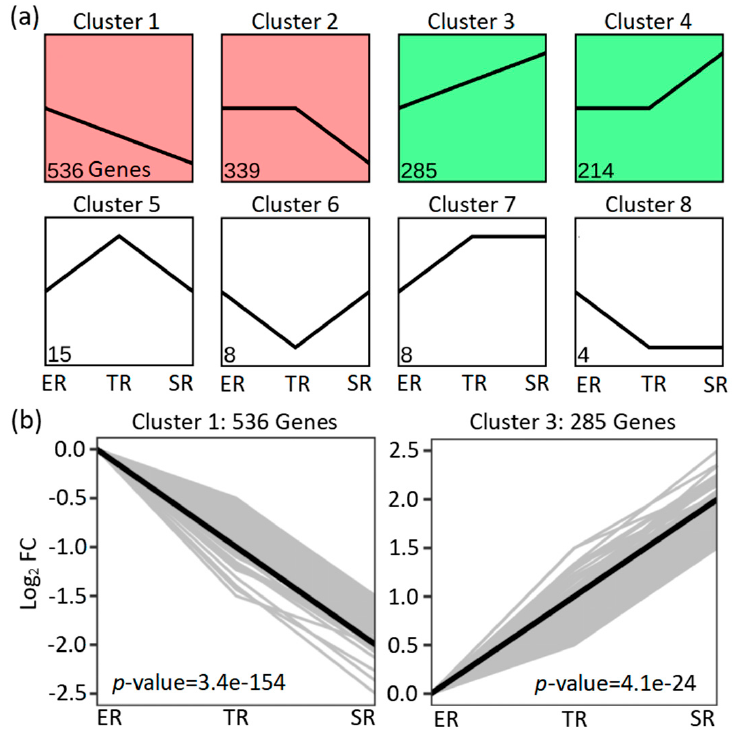
Figure 4. STEM analysis of 1409 DEGs based on significantly different genes in elongation region (ER), transition region (TR), and stable region (SR). ( a ) Eight expression clusters; ( b ) expression trends for genes in clusters 1 and 3.